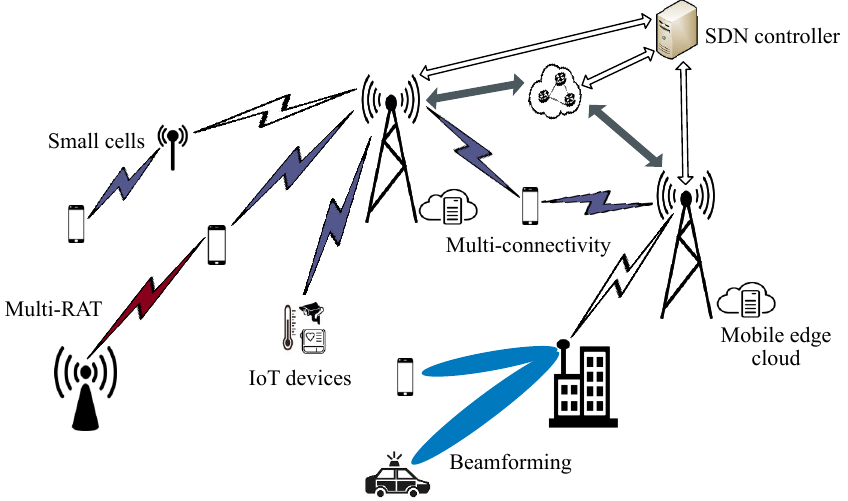
Figure 2. Examples of cellular technologies for next-generation public safety